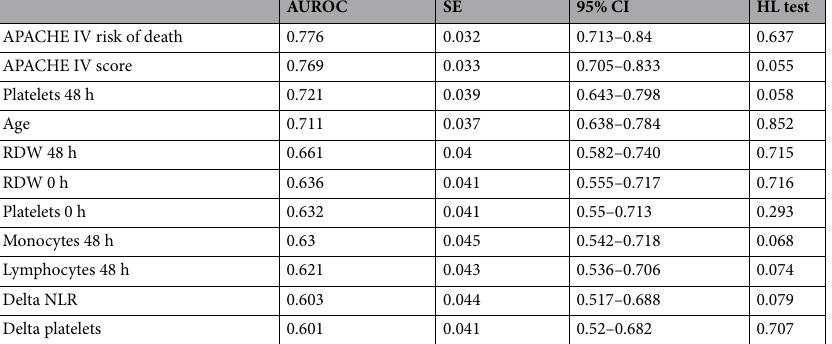
Table 3. Area under receiver operating characteristic curves (AUROC) for prediction of hospital mortality. APACHE IV Acute Physiology and Chronic Health Evaluation IV, NLR the neutrophil-to-lymphocyte ratio, RDW the red cell distribution width, AUROC area under receiver operating characteristic curves, CI confidence interval, HL test Hosmer ‒ Lemeshow goodness-of-fit test.